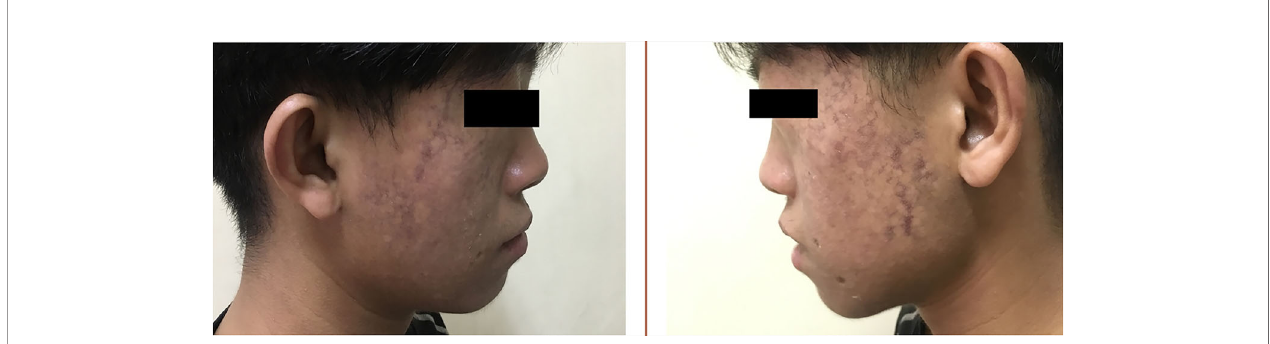
FIGURE 1 | Symmetrical erythema on the patient ’ s